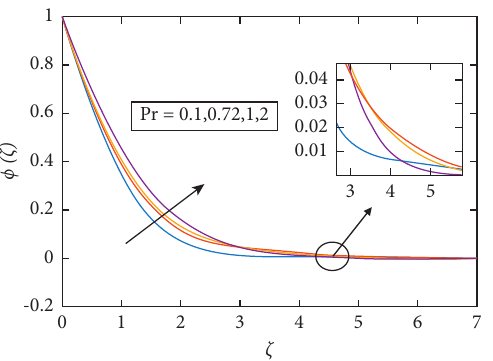
Figure 16: Pr variation on φ ( ζ )